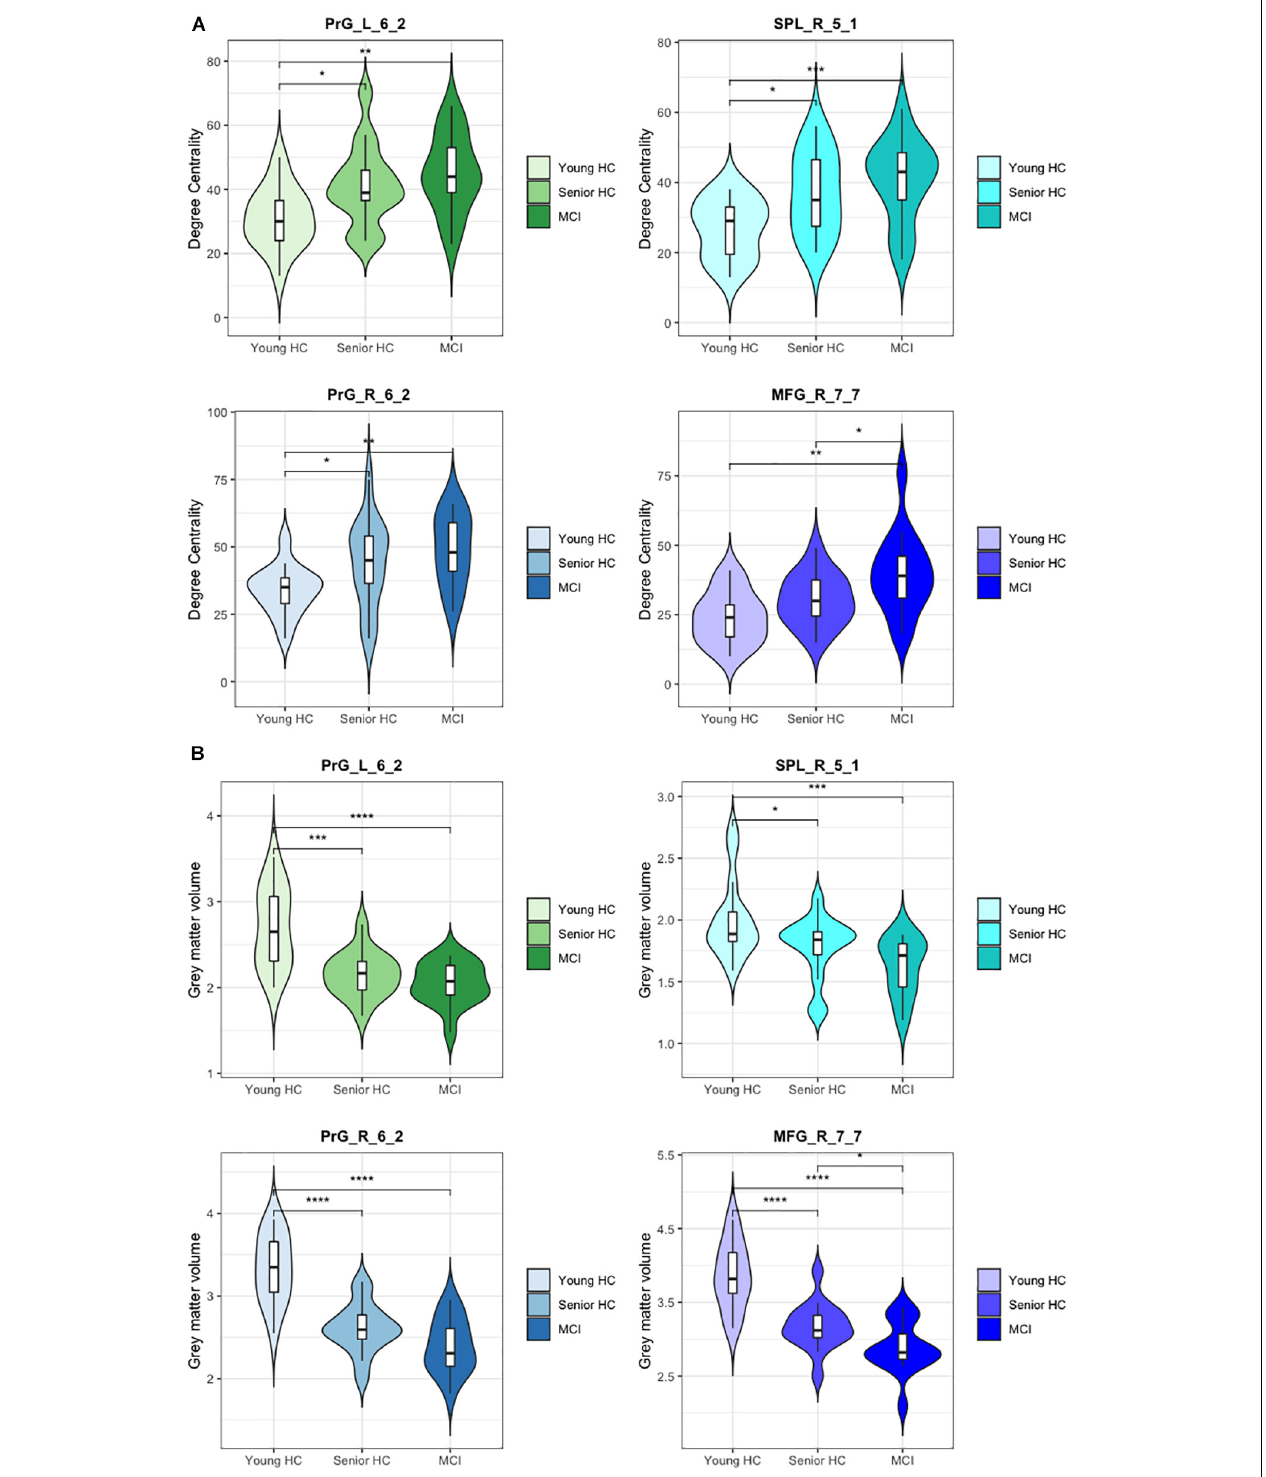
FIGURE 3 | Degree centrality and gray matter volume of compensatory ROIs. Illustration of (A) the degree centrality and (B) the gray matter volume of the right and the left precentral gyri caudal dorsolateral area 6 (Brainnetome label: PrG_R_6_2 and PrG_L_6_2), the superior parietal lobe, rostral area 7 (Brainnetome label: SPL_R_5_1), and the right middle frontal gyrus, lateral area 10 (Brainnetome label: MFG_R_7_7). (*) indicates statistical significance ( p < 0.05, FDR-Corrected), (**) indicates statistical significance ( p < 0.01, FDR-Corrected), (***) indicates statistical significance ( p < 0.005, FDR-Corrected), (****) indicates statistical significance ( p < 0.001,